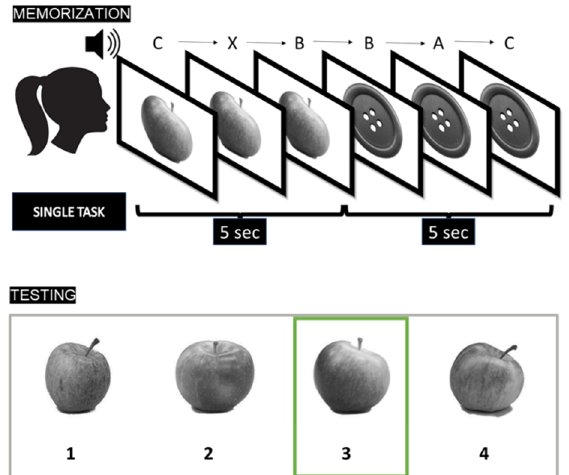
Figure 3. A representative sequence of the memory task. During the encoding phase ( upper panel ) 15 images were shown in sequence for 5 s each. Concurrently, a stream of 45 auditory stimuli (letters) was played with an onset asynchrony of 1666 ms. In the No-Load condition (NL), participants had to ignore the auditorily presented letters. In the Low-Load condition (LL), participants had to press a response key each time the letter “X” was presented. In the High-Load condition (HL), participants had to press a response key whenever the letter “X” was preceded by the letter “A”. During the testing phase ( lower panel ), a forced-choice image recognition was performed. One of the four images consisted of a previously presented (target) image (here image number 3, highlighted in green).